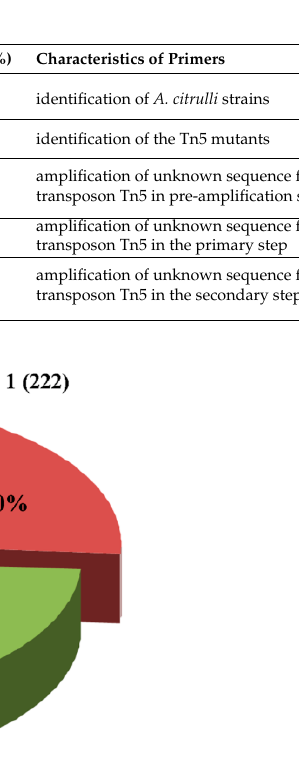
Table 1. Oligonucleotide primers used in this study for high-efficiency thermal asymmetric interlaced PCR.